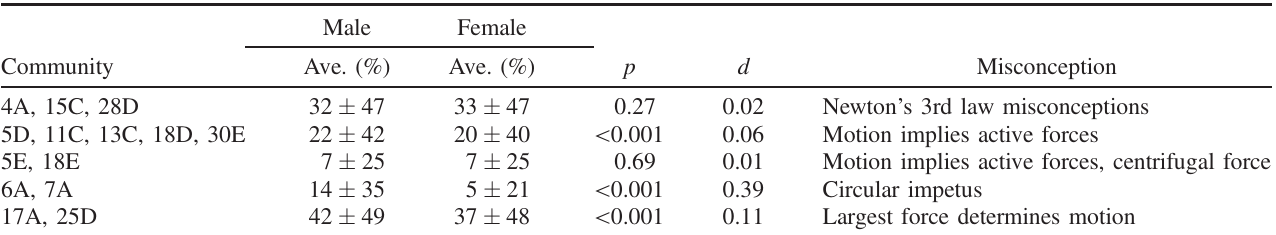
TABLE III. Percentage of students selecting each incorrect community for the FCI post-test ( C > 80% ). A t test was performed to determine if the differences between men and women were significant, the p value is presented. Cohen ’ s d for the difference is also